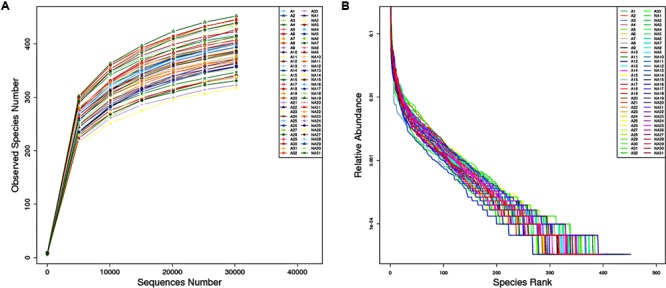
(A) Rarefaction curve for the number of operational taxonomic units (OTUs) observed in individual sample against sequences number. (B) Rank abundance curve. The horizontal axis shows the OTU abundance in rank order; the vertical axis shows the relative abundance of sequences on a logarithmic scale.